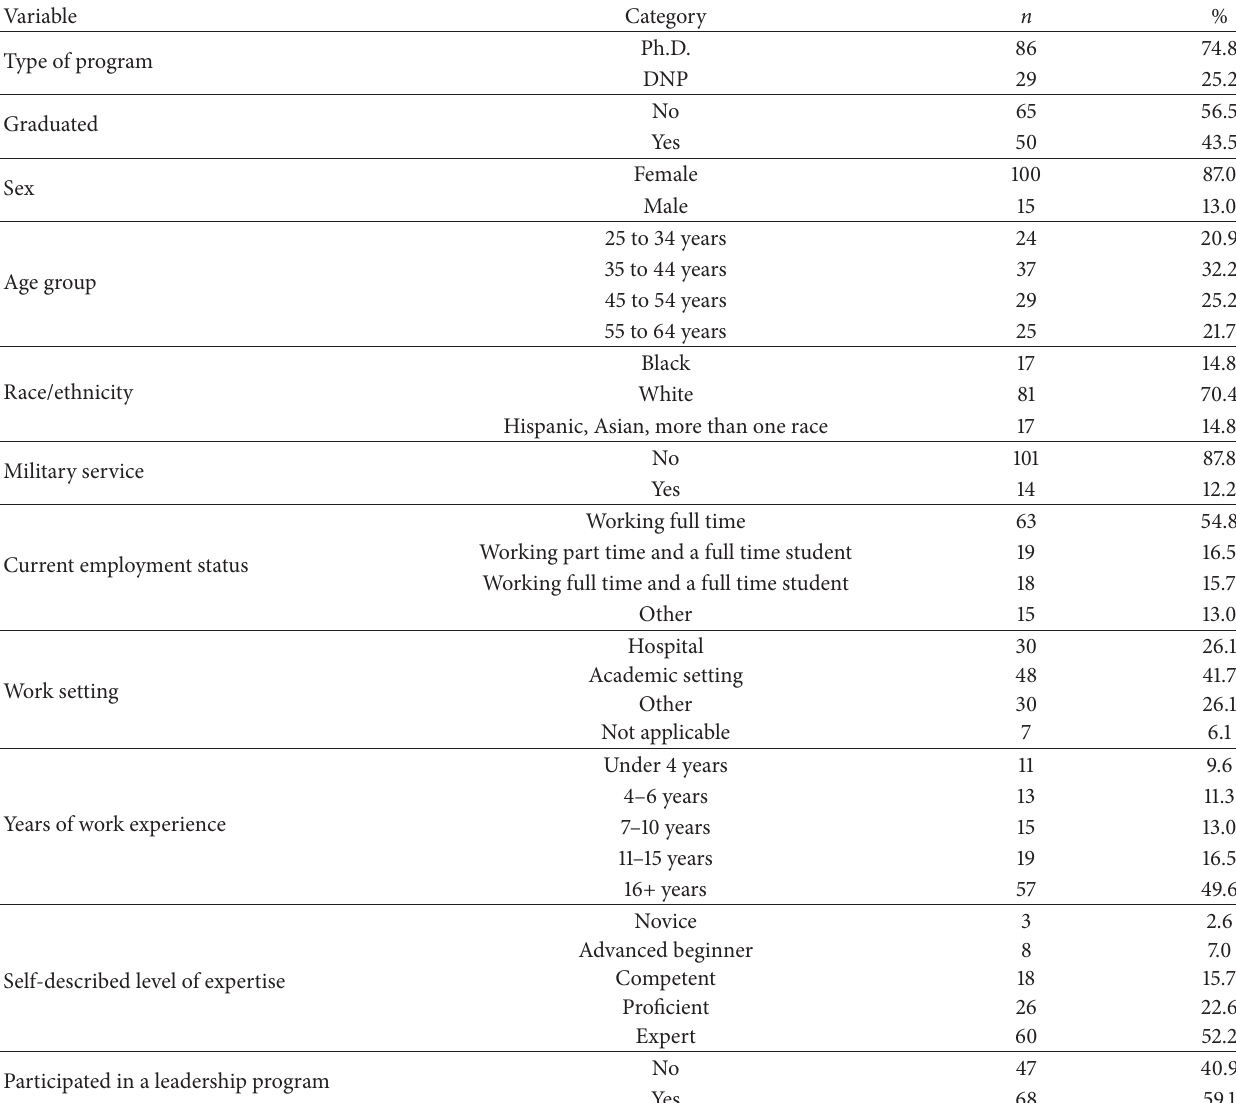
Table 1: Demographic data ( 𝑁 = 115